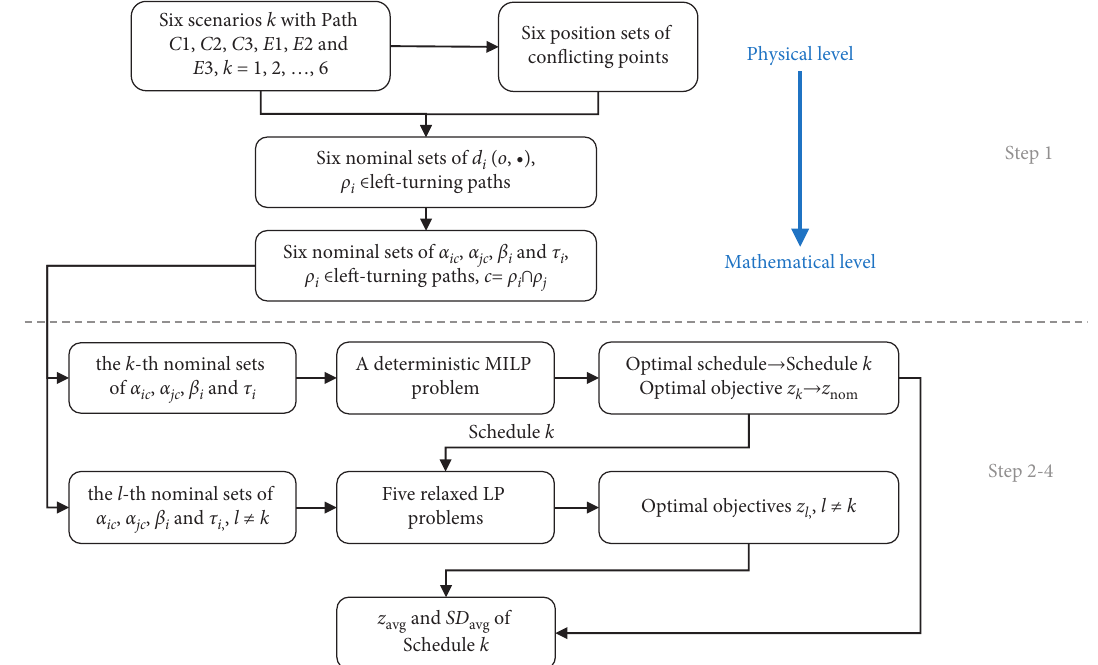
Figure 4: Procedure of the scenario-based